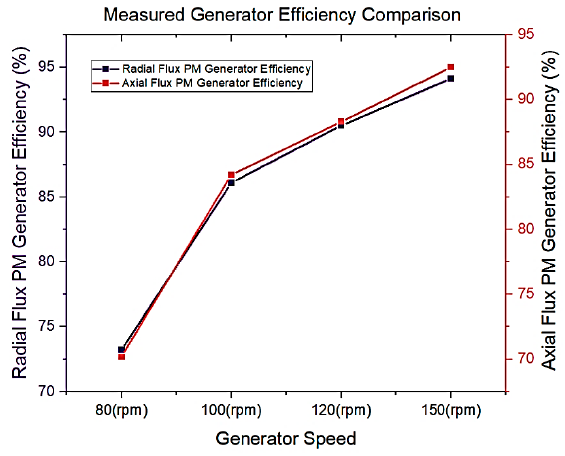
Figure 11. Measured generator efficiency comparison [34]. Energies 2019 , 12 , x FOR PEER REVIEW